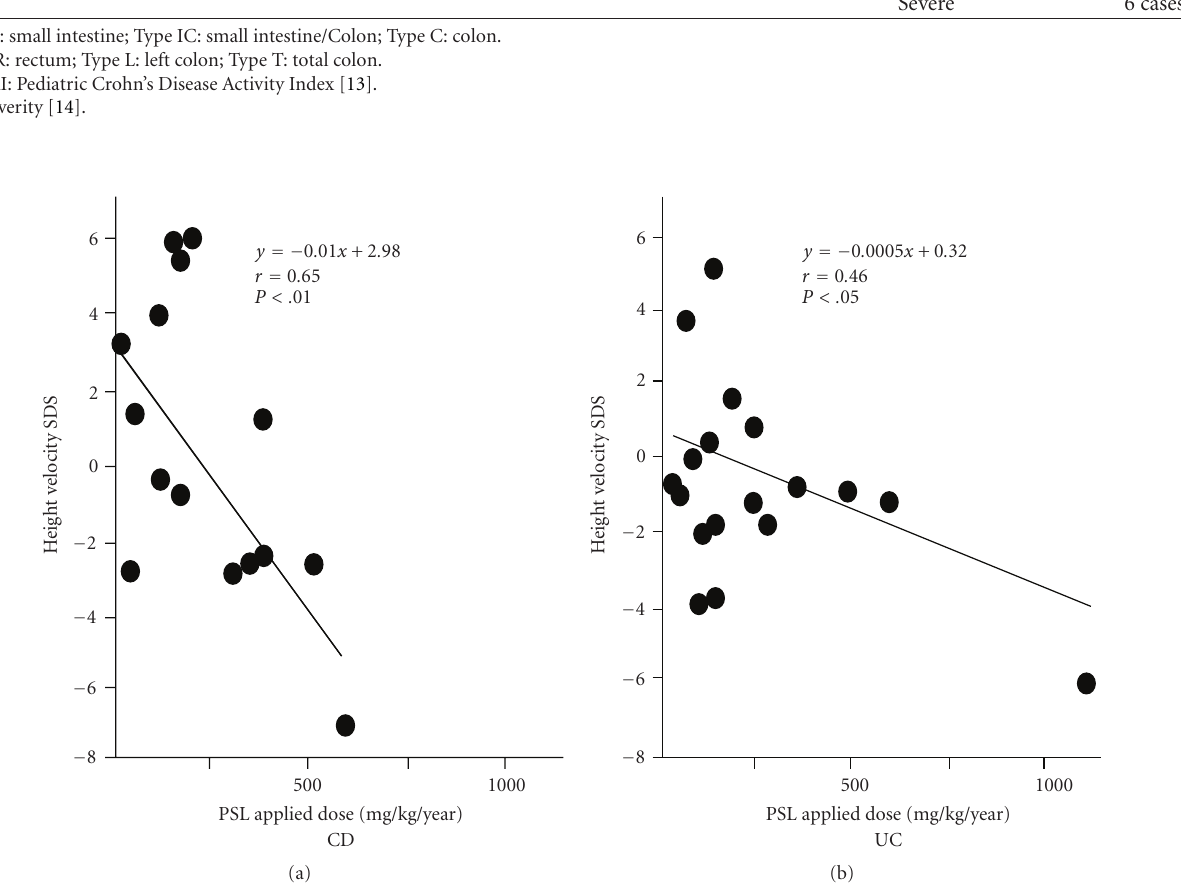
Figure 4: Correlation between growth rate SDS and the amount of PSL administered in children with CD and those with UC from the start of treatment to 1 year